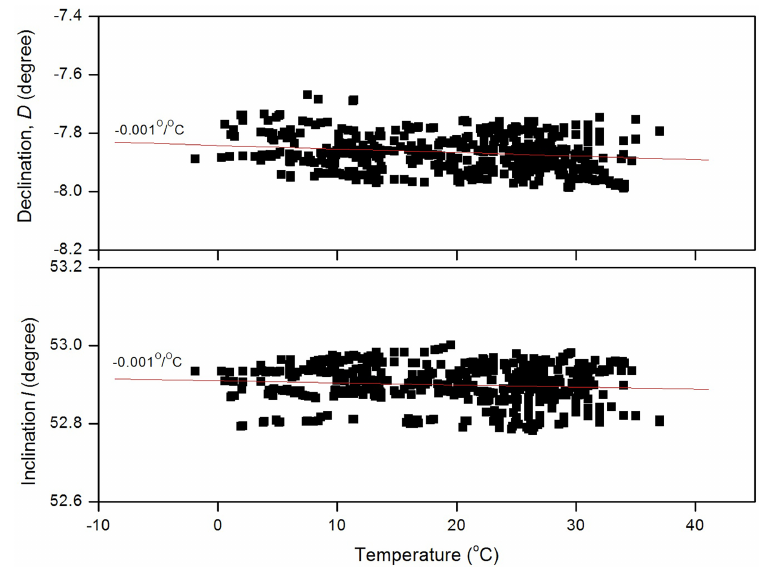
Figure 8. (Top) Declination and (bottom) inclination value plotted against temperature in the absolute-measurement hut.